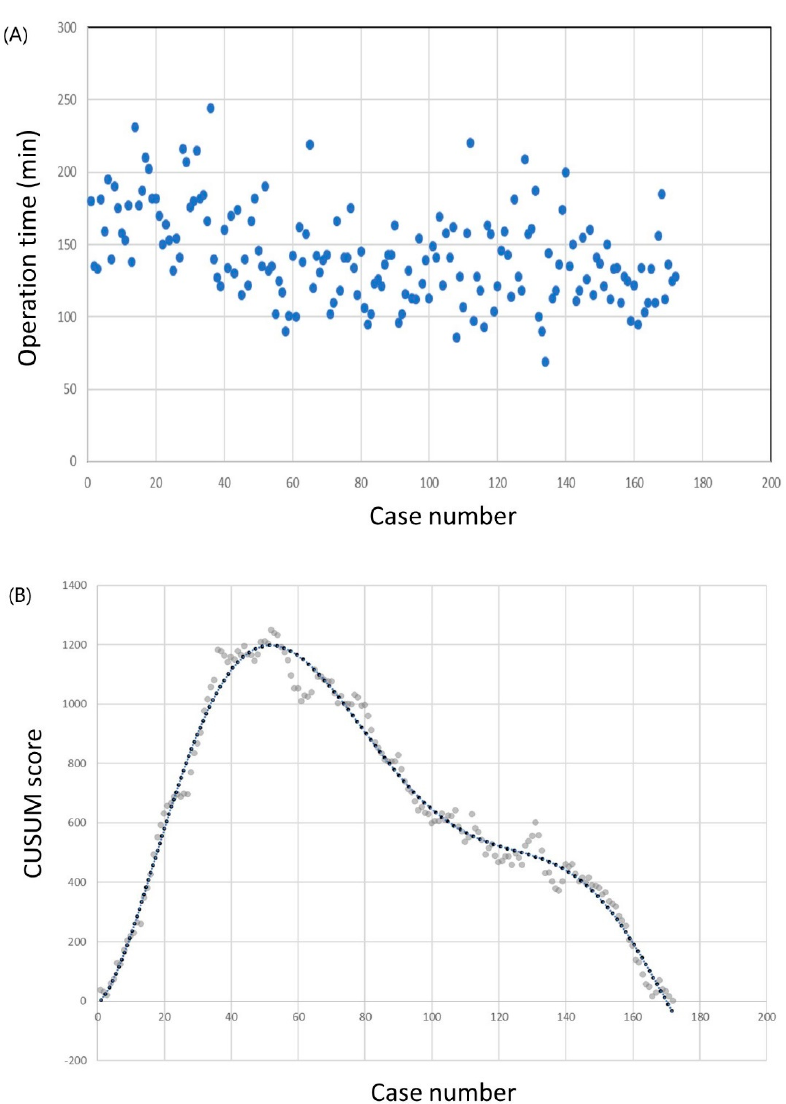
Figure 1. Operation time of the robotic thyroid surgery. ( a ) Operation time plotted in chronological order. ( b ) Cumulative summation test of operation time.